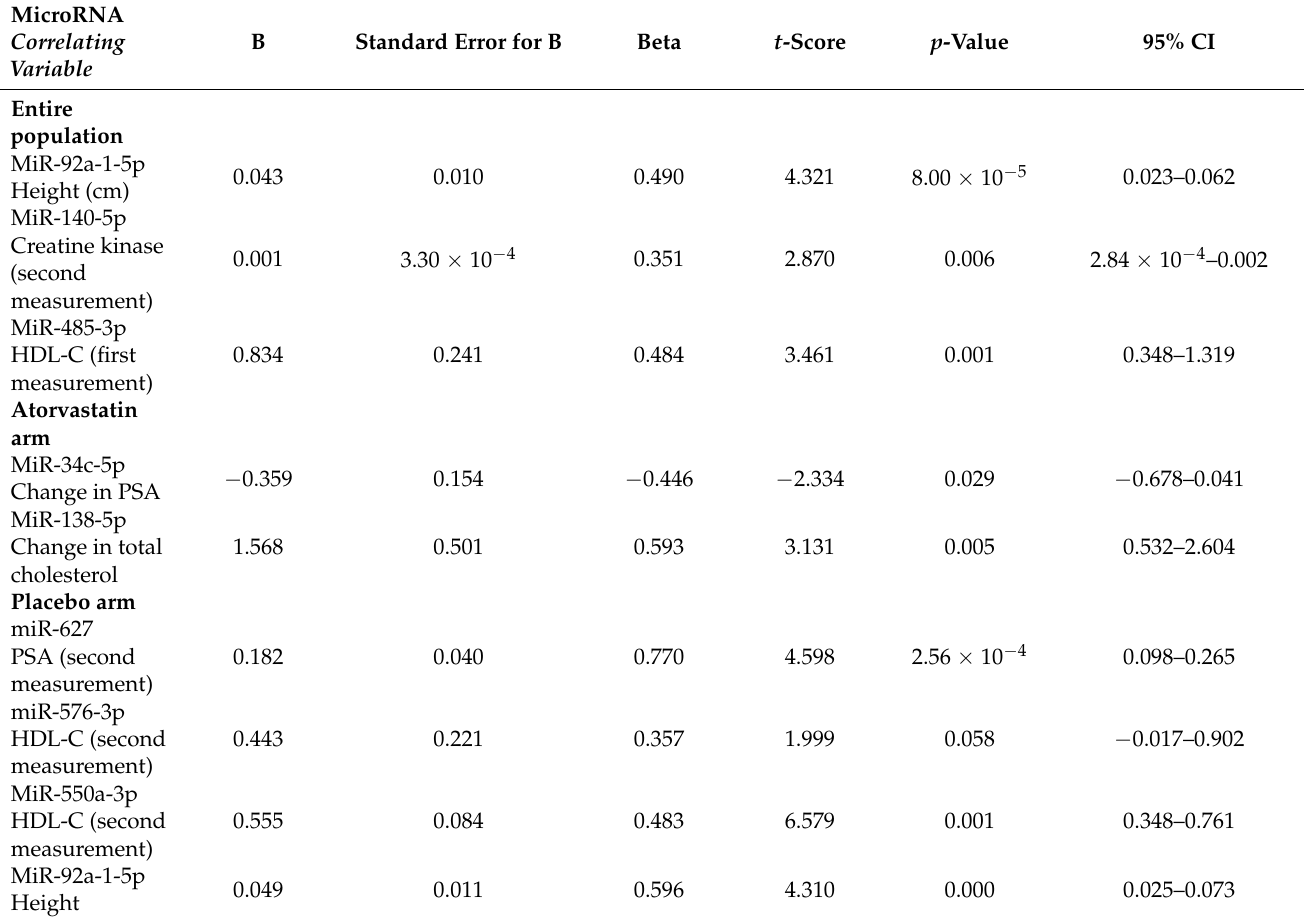
Table 3. Statistics from the regression models of the miRNAs with significant correlations. The models included correspond- ing miRNA as the dependent variable and age, BMI, smoking habits, Gleason grade of the tumor and the arm of the study as explanatory variables. In stratified analyses, the study arm was not an explanatory variable. B is the unstandardized regression coefficient and beta is the standardized coefficient for the variable of interest. 95% CI is the confidence interval for the